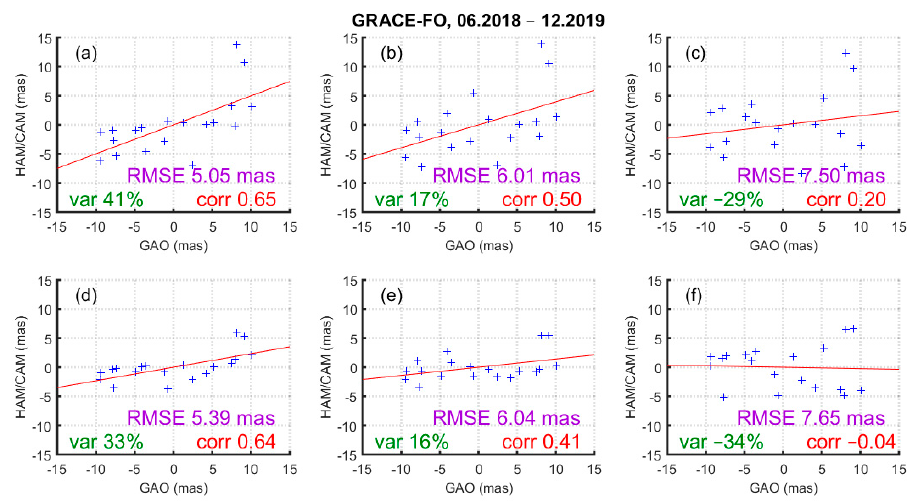
Figure 13. Scatter plots showing the relationship between the χ 2 component of GAO and HAM/CAM from ( a ) CSR GSM, ( b ) JPL GSM, ( c ) GFZ GSM, ( d ) CSR TWS, ( e ) JPL TWS, and ( f ) GFZ TWS. The red line was fitted to the data points using the least squares method. The values in purple indicate the RMSE, the values in red (corr) indicate the correlation coefficients between series, and the values in green (var) indicate the relative explained variances. The considered time period is June 2018 to December 2019. Note that the critical value of correlation coefficient for 12 independent points and a 95% confidence level is 0.50, while the standard error of the difference between two correlation coefficients is 0.47. All the parameters were computed after removal of trends.